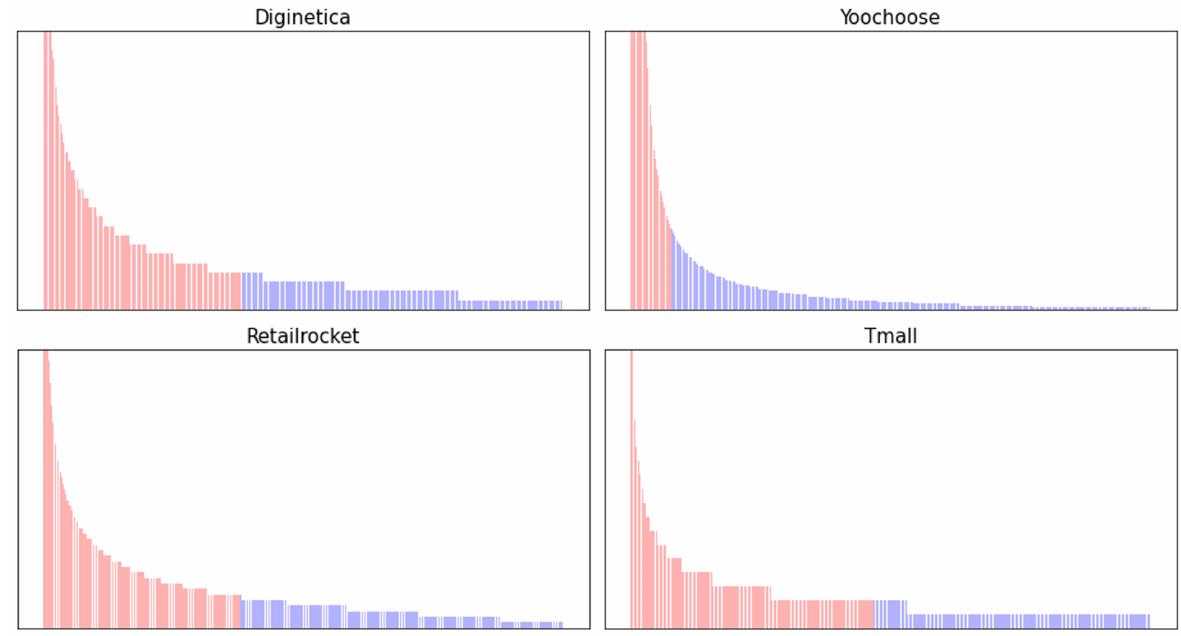
Figure 2. Long-tail distribution of real-world session datasets. From the left, the datasets are Diginetica, Yoochoose, Retailrocket, Tmall. The red part represents short-head and the blue part represents